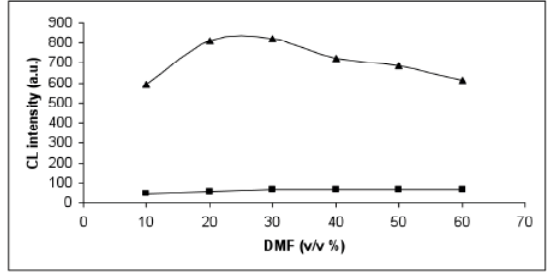
Figure 3. The effect of DMF (reagent 1) in the absence ( ■ ) and in the presence ( ▲ ) of 40 mg L -1 PVK. Reagent 1: 1% (w/v) CTMAB,